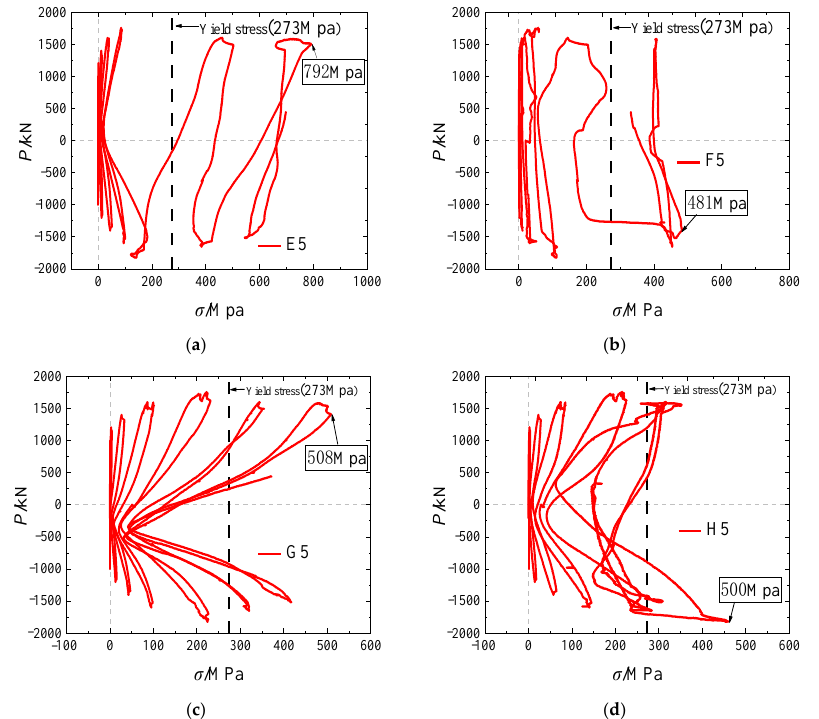
Figure 15. Load–stress curves of the steel plates at the side center of the RCFSTKs. ( a ) Steel plate stress at RCFSTK E5; ( b ) Steel plate stress at RCFSTK F5; ( c ) Steel plate stress at RCFSTK G5; ( d ) Steel plate stress at RCFSTK H5.